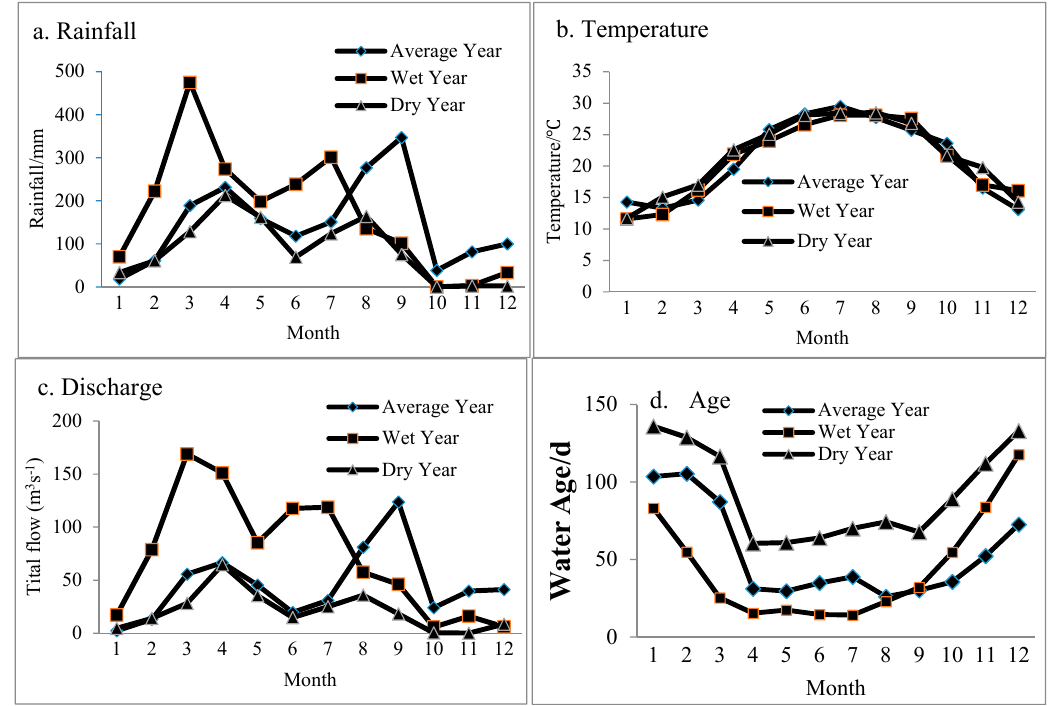
Figure 8. Monthly rainfall ( a ); temperature ( b ); discharge ( c ); and water age ( d ) in different years.